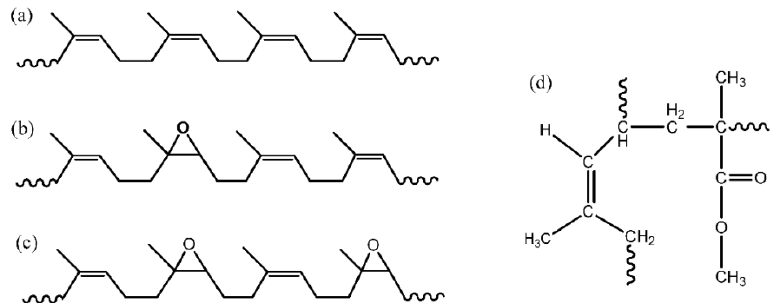
Figure 12. Structure of ( a ) natural rubber, ( b ) ENR-25, ( c ) ENR-50, and ( d ) MG-30 and MG-49.